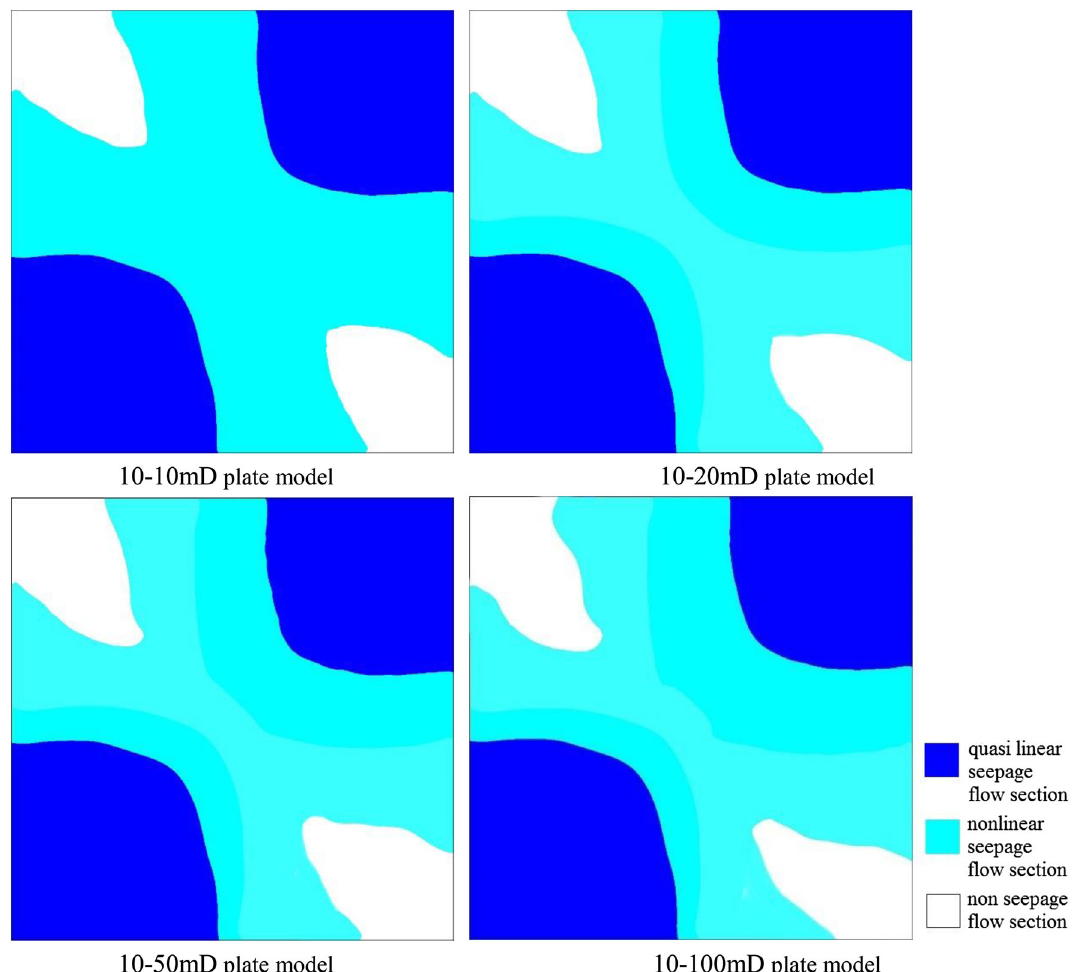
Fig. 9 Sketch map of seepage flow section of heterogeneous low-permeability plate